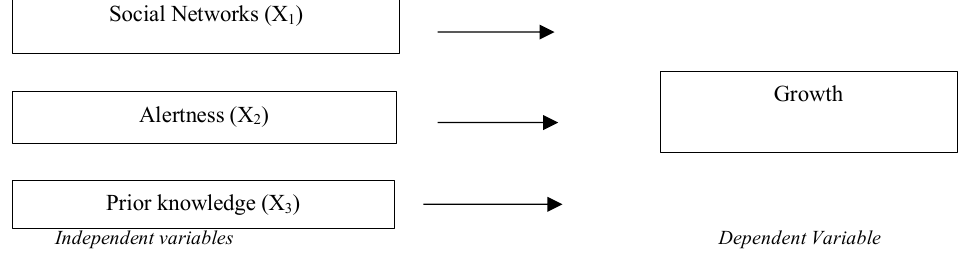
Figure 1: Conceptual